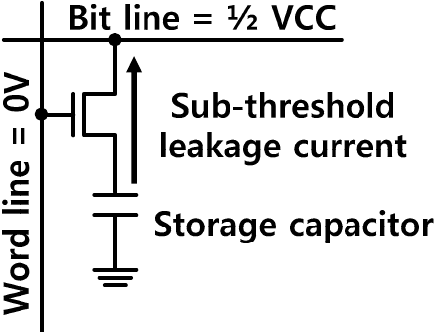
Figure 1. A subthreshold leakage current in the dynamic random access memory (DRAM) access transistor .